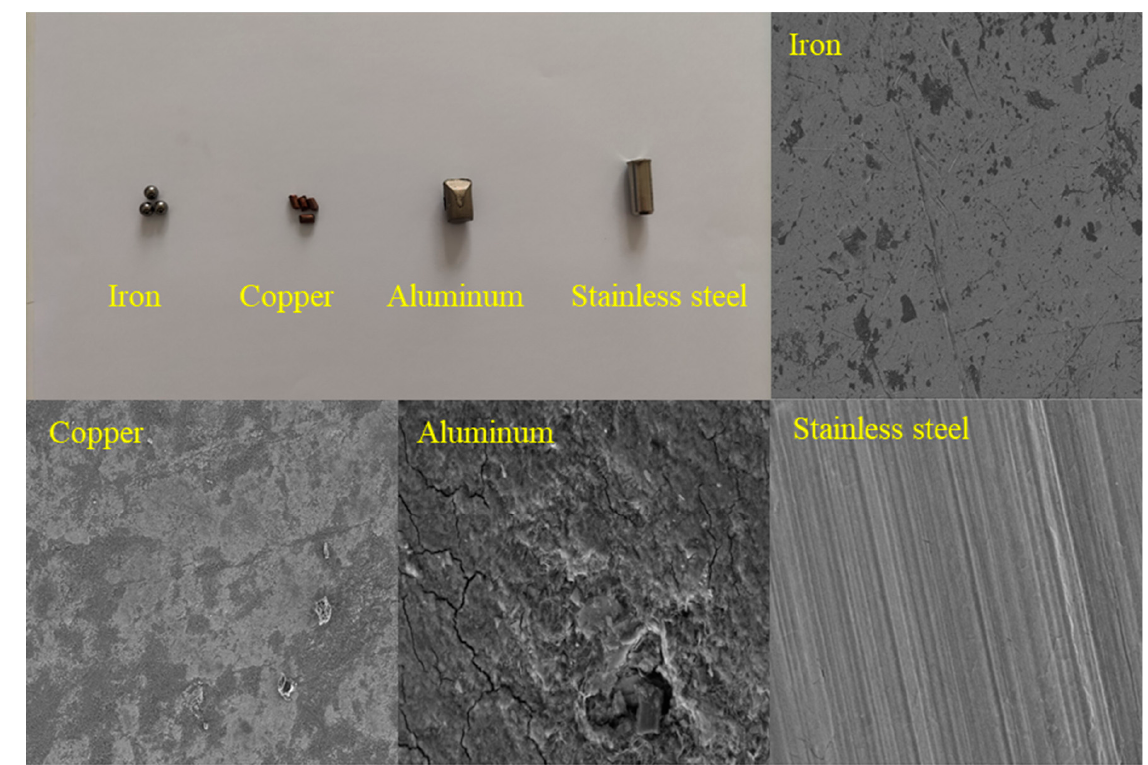
Figure 14. Surface color and SEM image of four metals after the reaction.